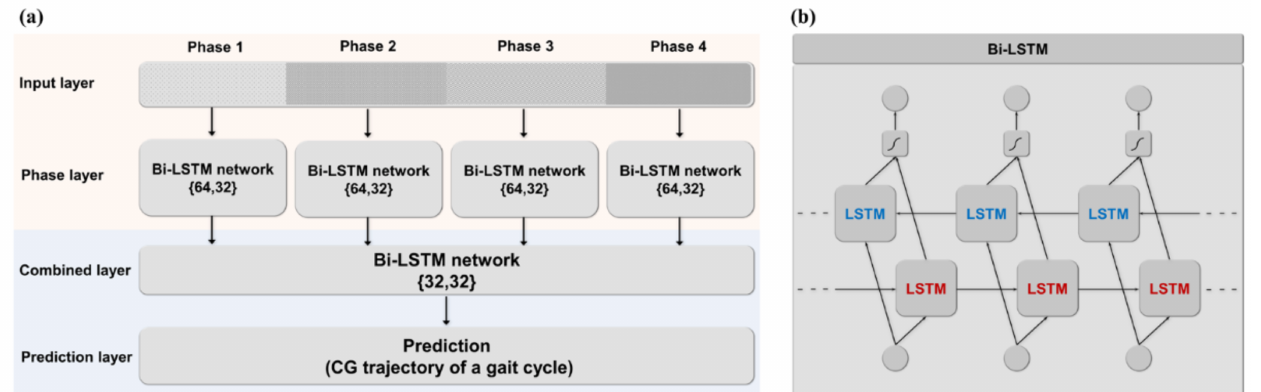
Figure 7. Details of prediction model using Bi-LSTM network. ( a ) prediction model structure ( b ) architecture of Bi-LSTM